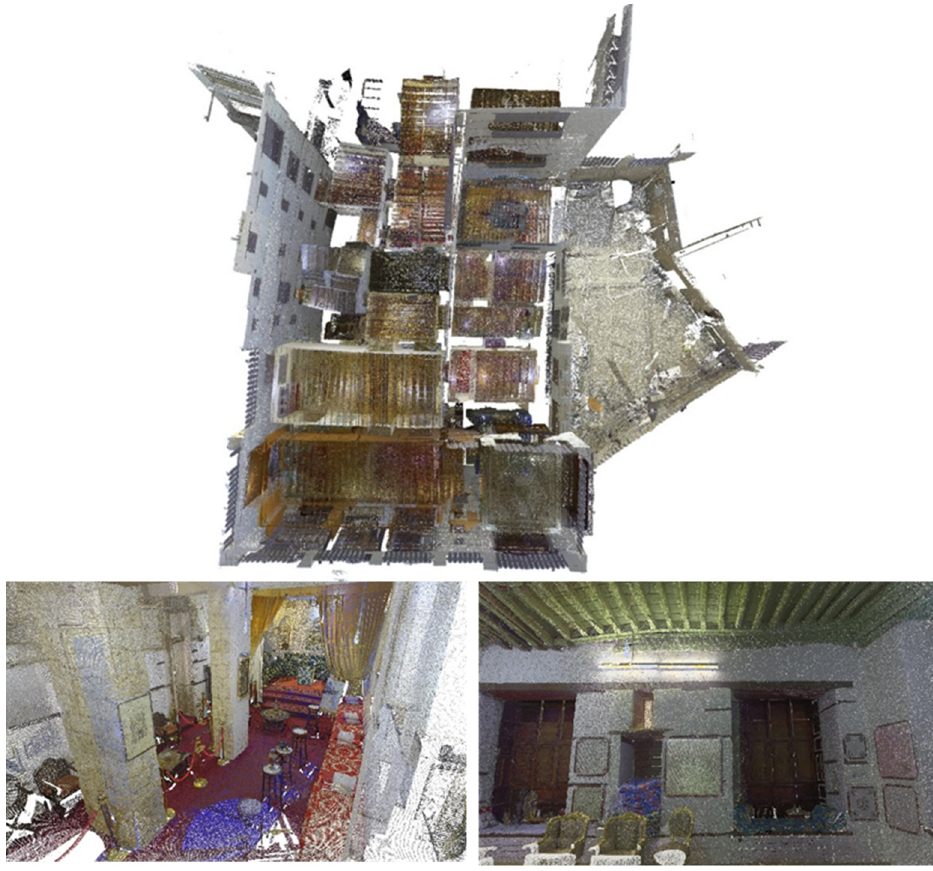
Figure 8. Colored 3D point cloud for the interior of the Matbouli House